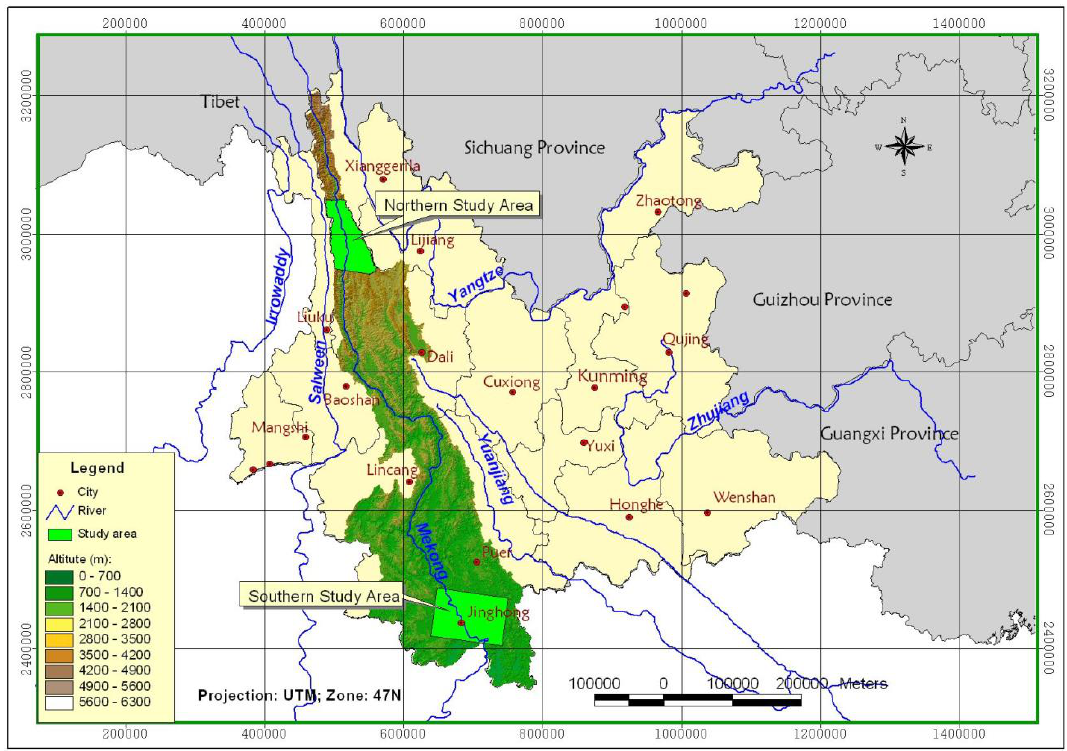
Figure 1. Location of the two study